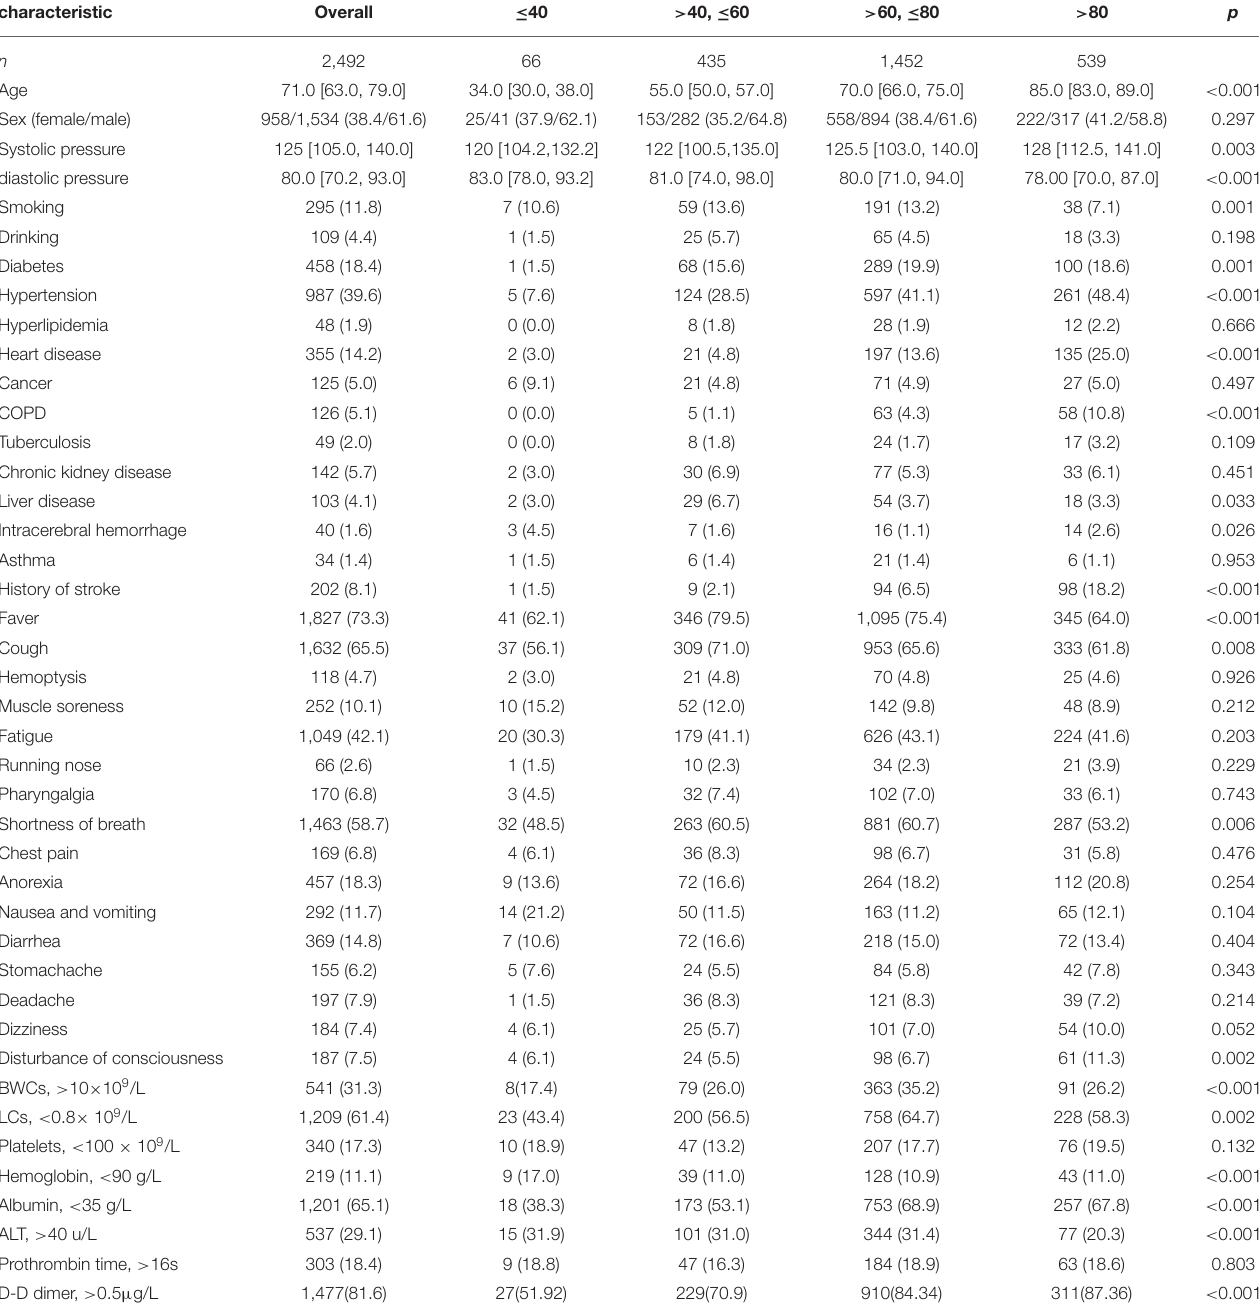
TABLE 2 | Baseline characteristics and outcomes of deceased patients with COVID-19 in different age groups.